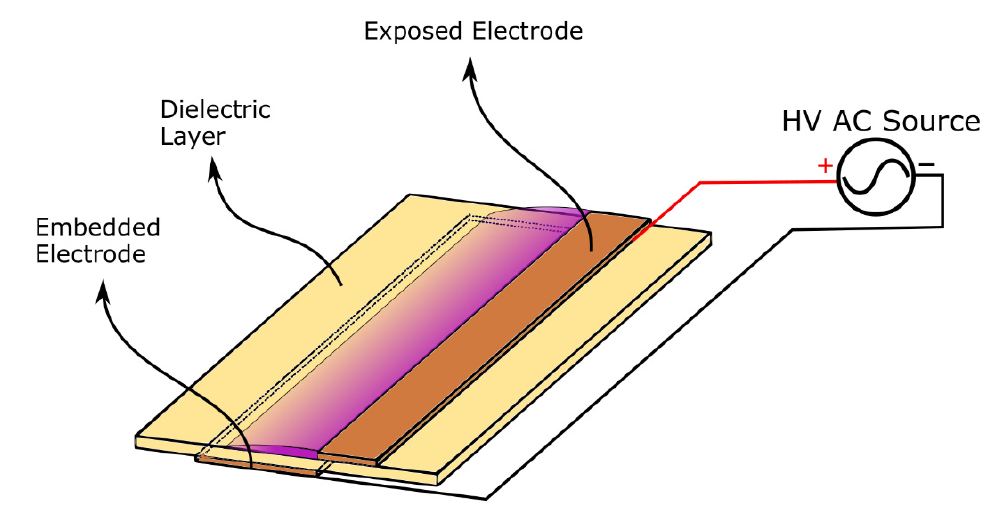
Figure 6. Schematic representation of surface DBD (SDBD) plasma actuator configuration.